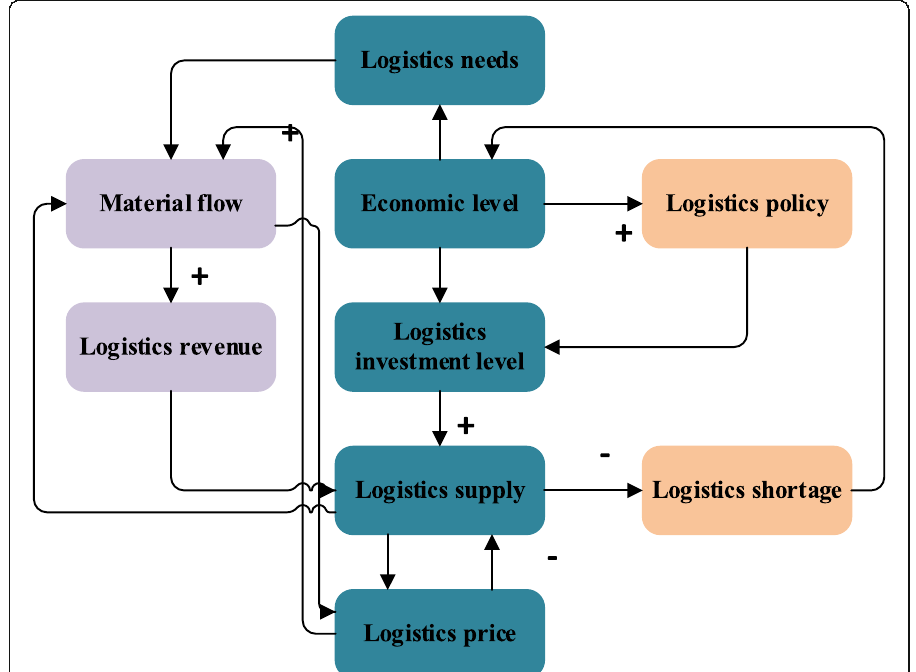
Fig. 2 Basic causal relationship between modern logistics and regional economic